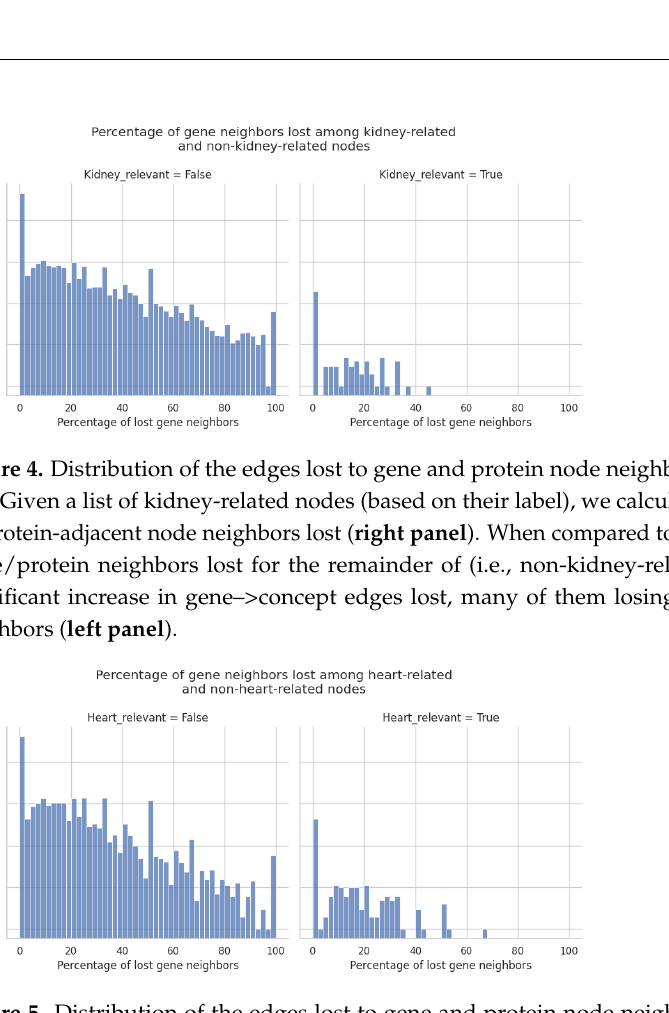
Figure 5. Distribution of the edges lost to gene and protein node neighbors for the heart-specific KG. Given a list of heart-related nodes (based on their label), we calculate the percentage of gene or protein adjacent node neighbors lost ( right panel ). When compared to the percentage of adjacent gene/protein neighbors lost for the remainder of (i.e., non-heart-related) nodes, we can see a signifi- cant increase in gene–>concept edges lost, many of them losing up to all gene or protein neighbors ( left panel